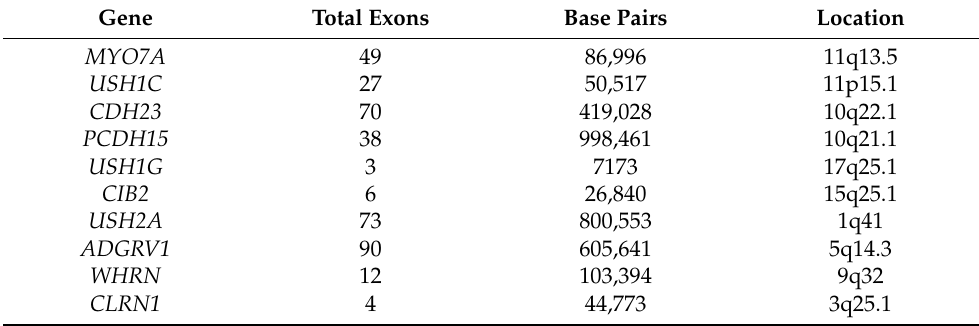
Table 4. Table of Usher gene size, exons, and location in the genome (Used hg38 in the UCSC (University of California Santa Cruz) Databank).